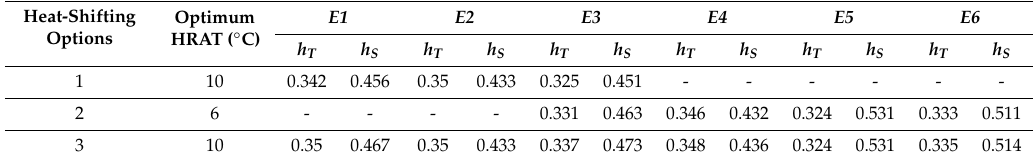
Table A10. Heat transfer coe ffi cients for exchangers’ tube and shell sides (kW / m 2 · ◦ C) of the a ff ected exchangers in HEN for option 1, 2 and 3 at optimum HRAT.